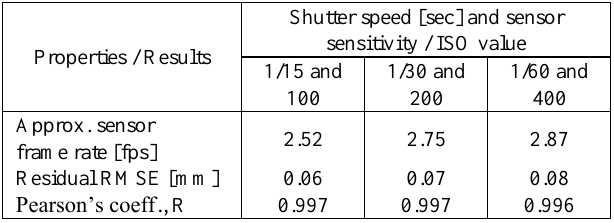
Table 2. Summary of the approximate sensor frame rate and the sinusoidal fitting results for three medium resolution